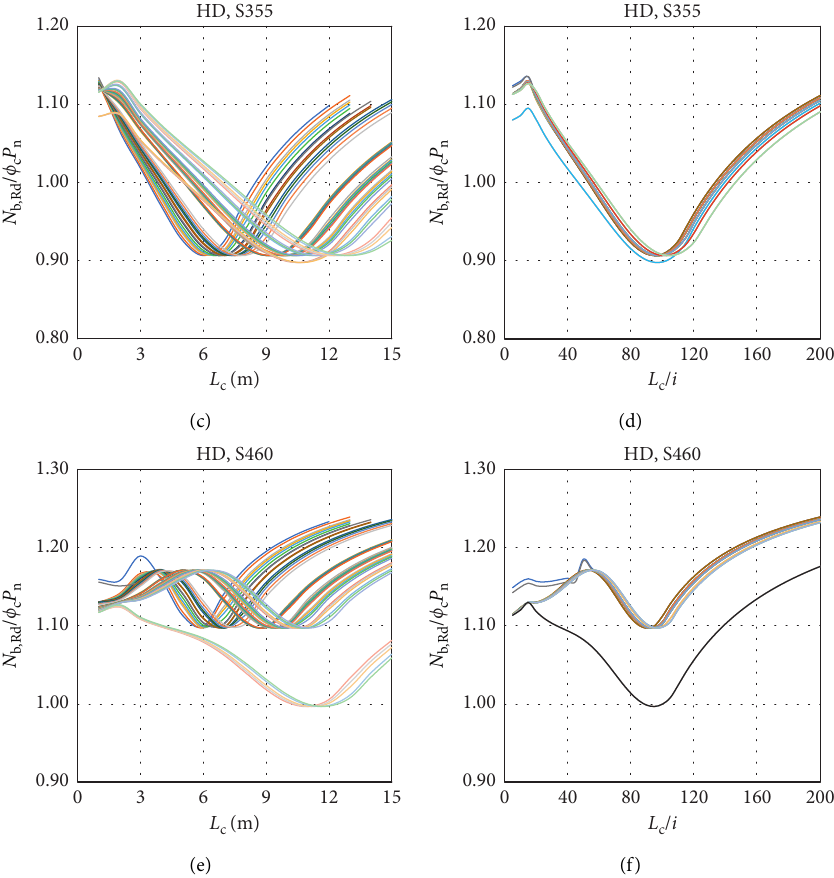
Figure 13: Variation of capacity ratio with buckling length L c (a, c, e) and with member slenderness L c / i (b, d, f) for studied HD